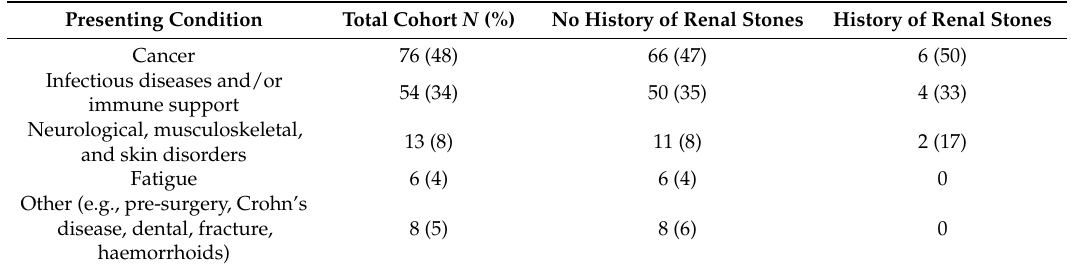
Table 2. Presenting conditions of